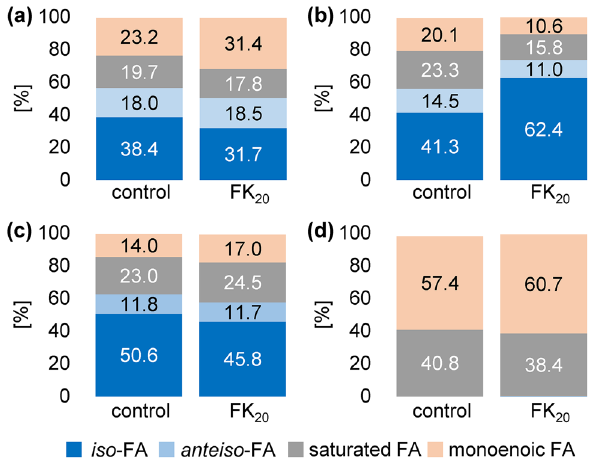
Figure 1. Percentage distribution of fatty acid groups (Σ iso -FAs, Σ anteiso -FAs, Σsaturated FAs and Σmonoenoic FAs) of ( a ) Xanthomonas campestris pathovar (pv) campestris ( X. campestris ), ( b ) Xanthomonas perforans ( X. perforans ), ( c ) Clavibacter michiganensis ( C. michiganensis ), and ( d ) Pseudomonas syringae pv. tomato ( P. syringae ) samples without treatment (control) and with FK 20